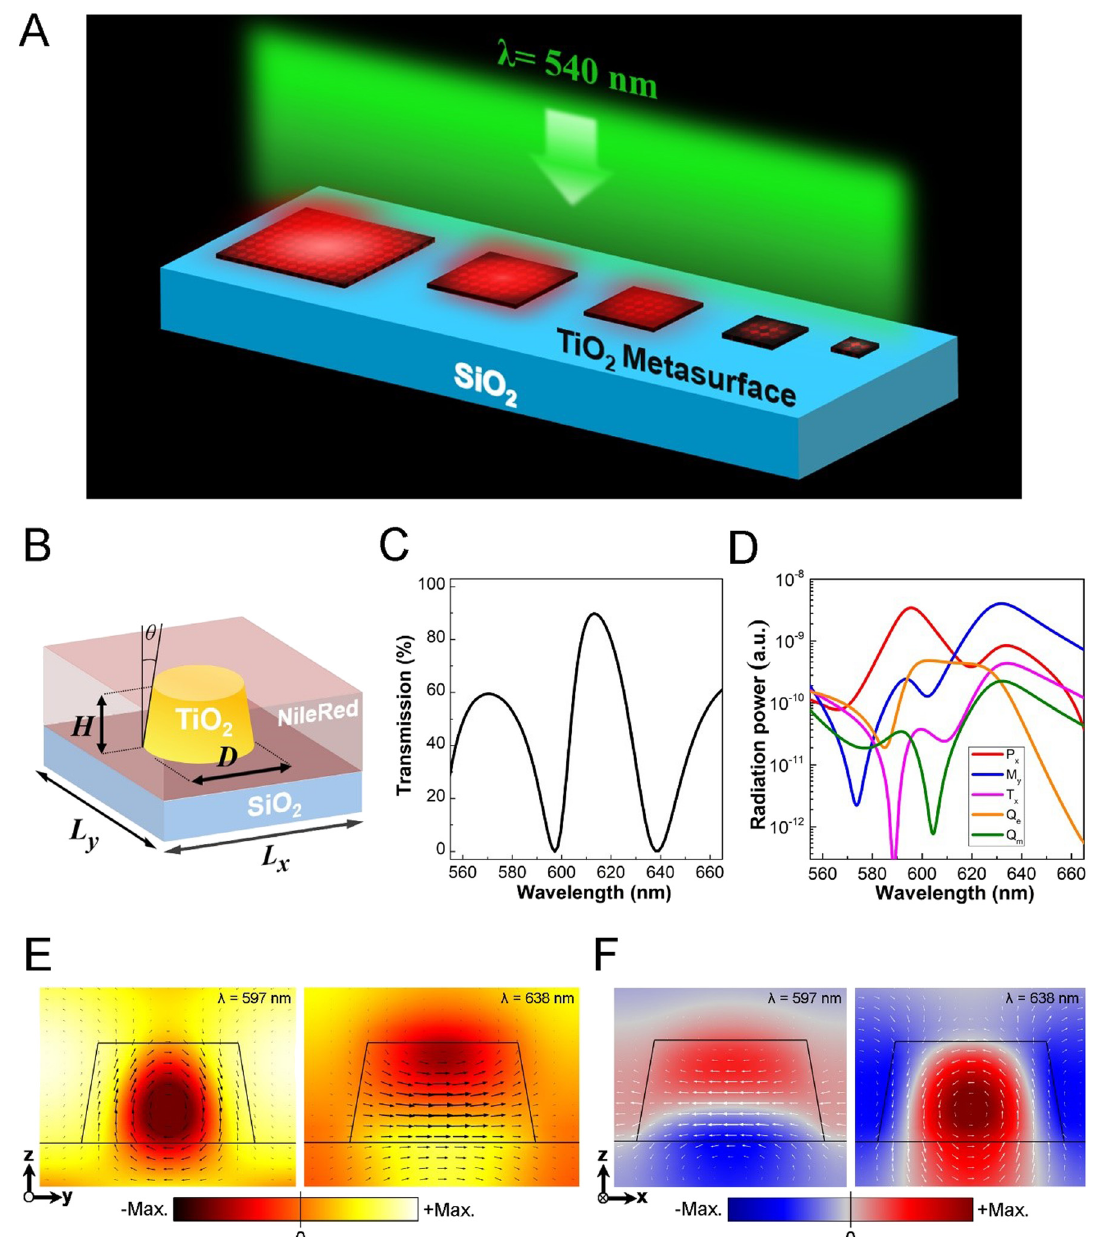
Figure 1: (A) A conceptual depiction of PL modification via all-dielectric metasurface array size. Due to the coherent resonance in the TiO 2 metasurfaces, the PL intensity becomes higher as the array size increased. (B) Schematic illustration of the TiO 2 dielectric metasurface unit standing on a SiO 2 substrate. The diameter of the bottom of the nanofrustum D = 315 nm; the height H = 170 nm; the periodicity along x -direction L x and y -direction L y are 410 and 490 nm, respectively. θ represents the sidewall tapering angle that is fi xed at 9 ° in this work. The dielectric metasurface is covered by a layer of fl uorescent dye Nile red (NR) for emission control. (C) Simulated transmission spectra of the integrated TiO 2 -NR metasurface under an x -polarized illumination. (D) Calculated scattered power of the dielectric metasurface embedded in the NR for individual electromagnetic multipoles. P i : i component of electric dipole, M i : i component of magnetic dipole, T i : i component of toroidal dipole, Q e : electric quadrupole, Q m : magnetic quadrupole. Numerical (E) x -component of electric and (F) y -component of magnetic fi eld distributions of the electric resonant mode (597 nm) and magnetic resonant mode (638 nm) of the TiO 2 metasurface. Black arrows and white arrows respectively represent the magnetic fi eld and the electric fi